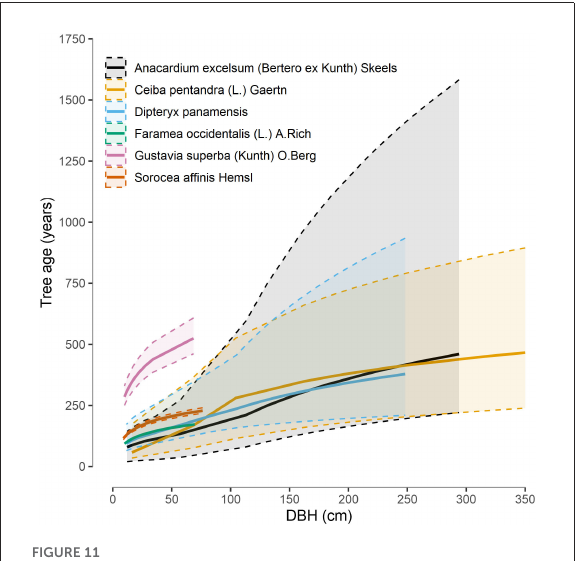
FIGURE11 Age estimates by diameter at breast height (DBH) for seven species in our study based on their recorded relative growth rates (RGR) on Barro Colorado Island. Means (thick lines) and 95% confidence intervals (dashed lines) were derived from 228 trees (RS +